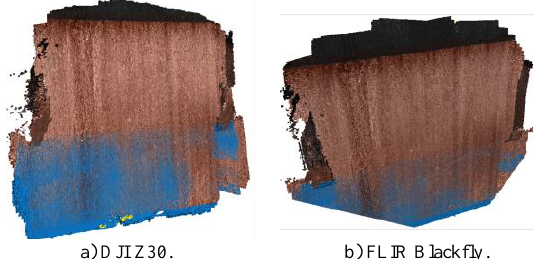
Figure 13. Unsatisfactory 3D reconstruction from simulated